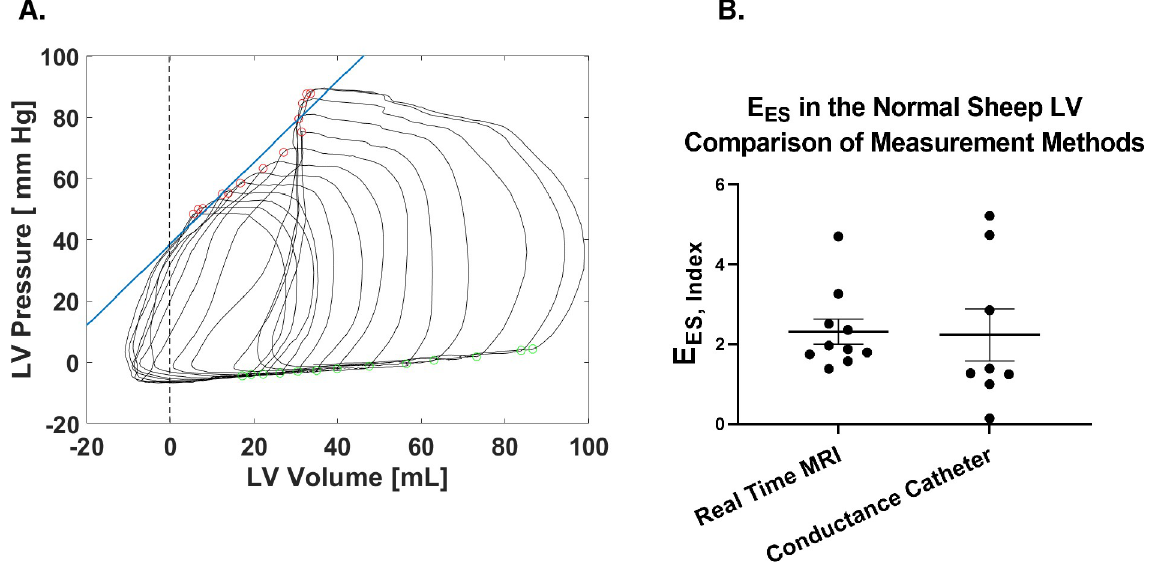
Fig 10. Representative conductance catheter PV loops (A) . Comparison of E ES,Index measured with RT and conductance catheter methods (B) indexed to body surface area. Green makers = end-diastole (ED), Red markers = end-systole (ES).